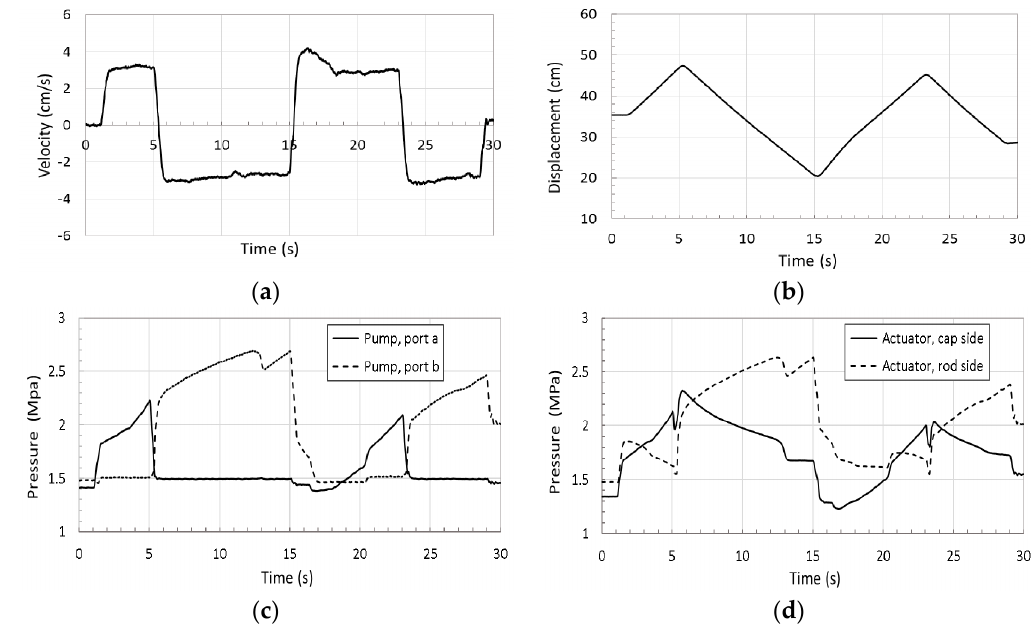
Figure 12. Performance of the proposed circuit for control signal in Figure 10 at four quadrants of operation and 41 kg mass: ( a ) actuator velocity, v a ; ( b ) actuator displacement; ( c ) pressures at pump ports a, p a and b, p b ; and ( d ) pressures at actuator ports a, p A and b, p B